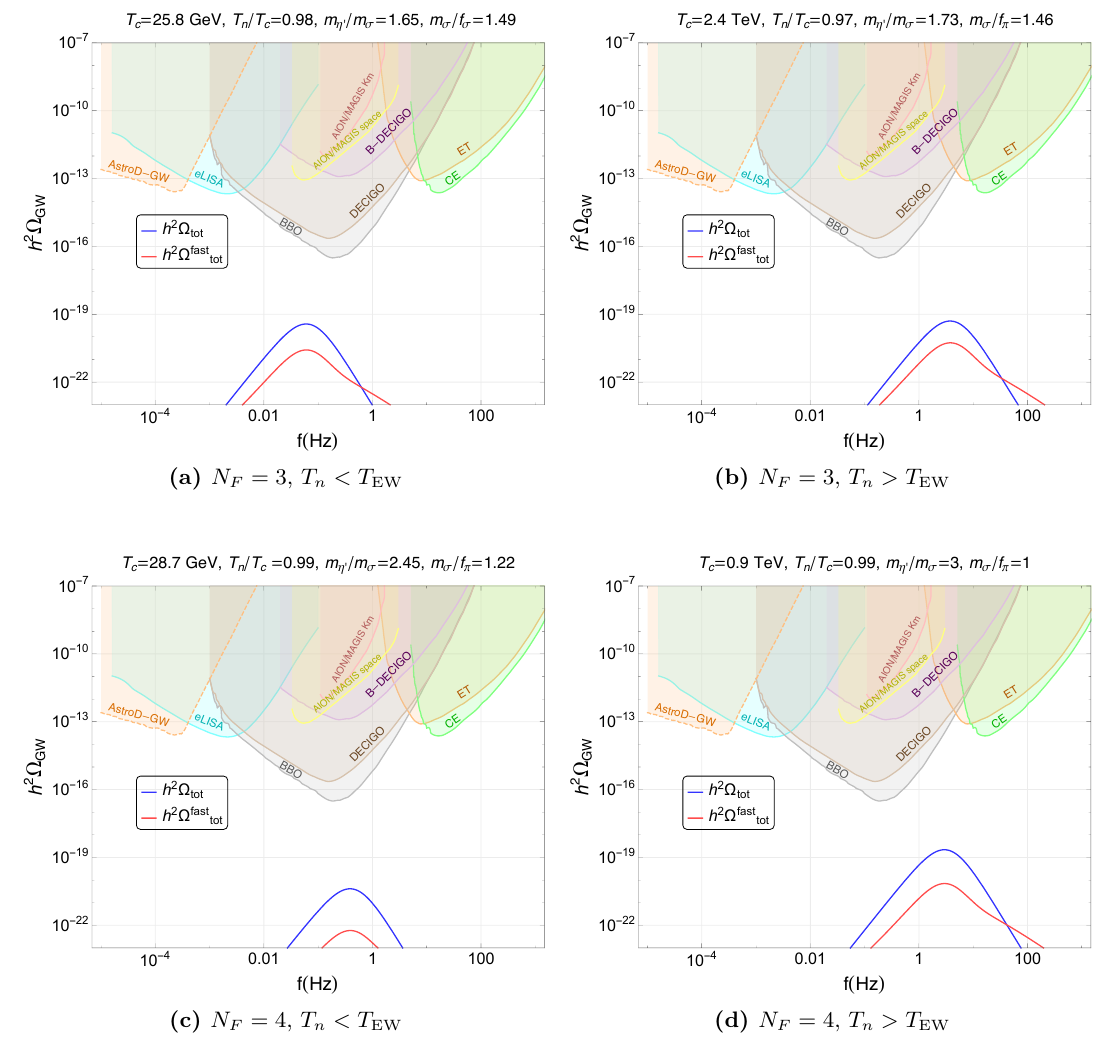
Figure 4. Gravitational wave spectrum for a strongly interacting sector with a QCD-like spectrum, see the definition in section 4.2. The parameters of the benchmark points shown are collected